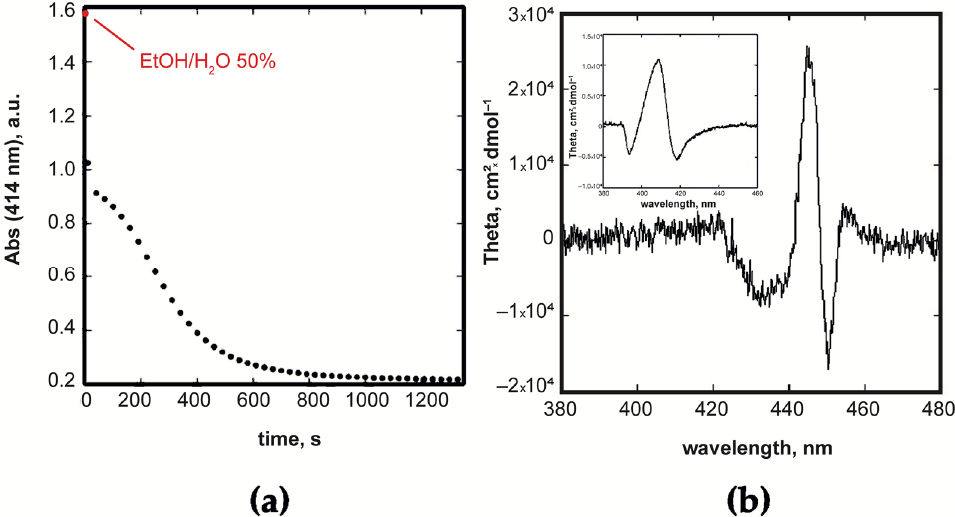
Figure 4. ( a ) Kinetic course for the aggregation of CuP(L)Pro(+) showing the occurrence of an initial burst followed by a slow autocatalytic step. The initial point (t 0 ) is calculated in non-aggregative conditions (50 % hydroalcoholic medium). ( b ) CD plot for the aggregates of ZnP(L)Pro(+) ; in the inset is reported the analogous spectrum for the CuP(L)Pro(+) derivative. Adapted from [69], with permission from the Royal Society of Chemistry, Copyright © 2019.